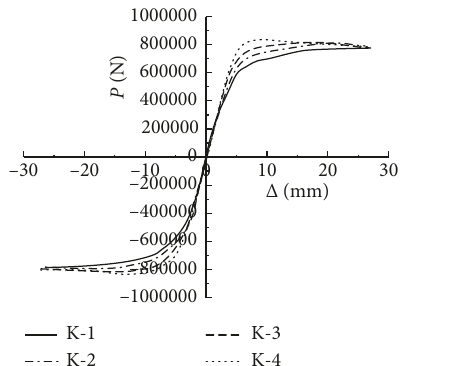
Figure 7: Skeleton curves of frames with various concrete strength levels.